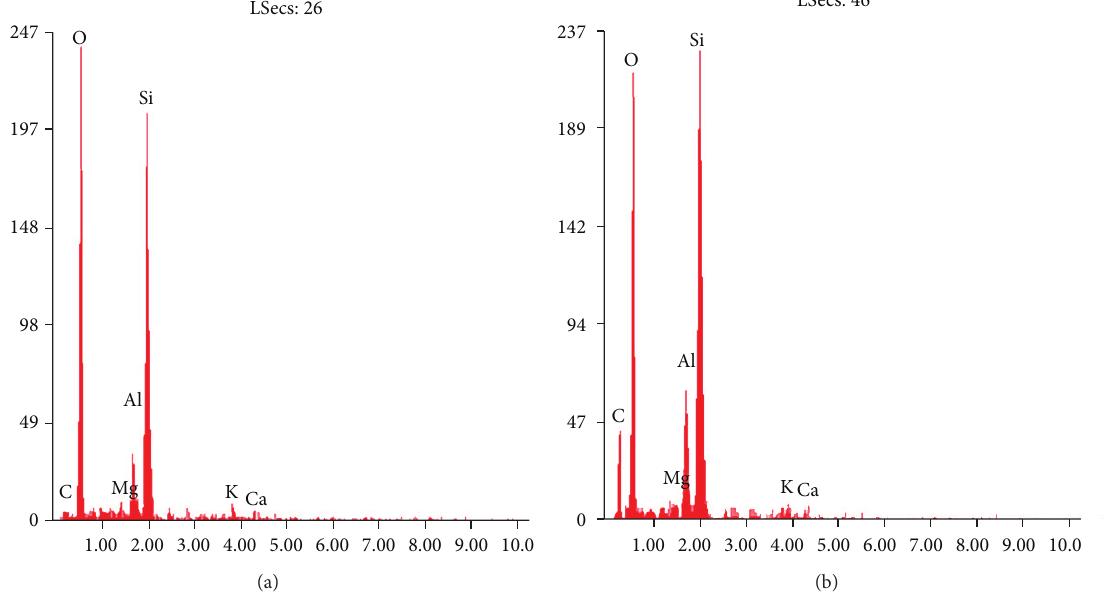
Figure 3: Semiquantitative elemental analysis provided by EDX.